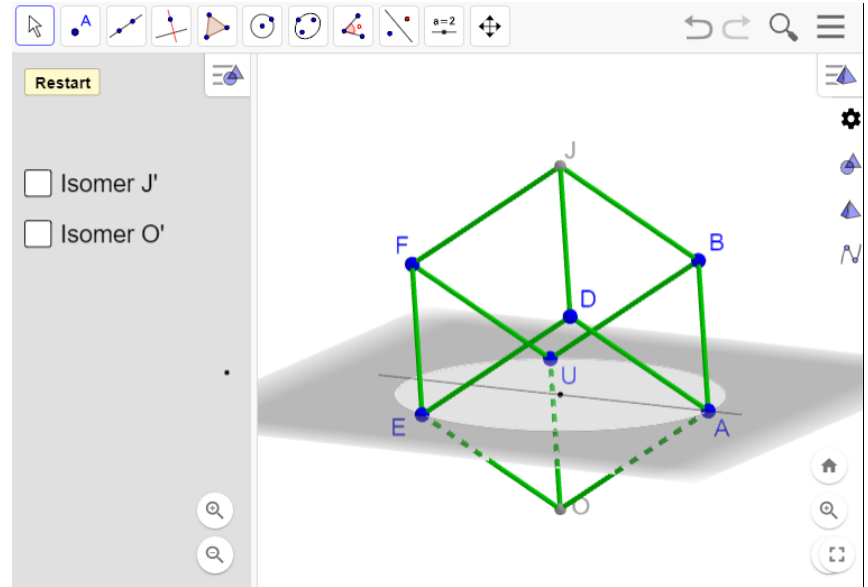
Figure 16. A uniform distribution of six degrees of freedom among six